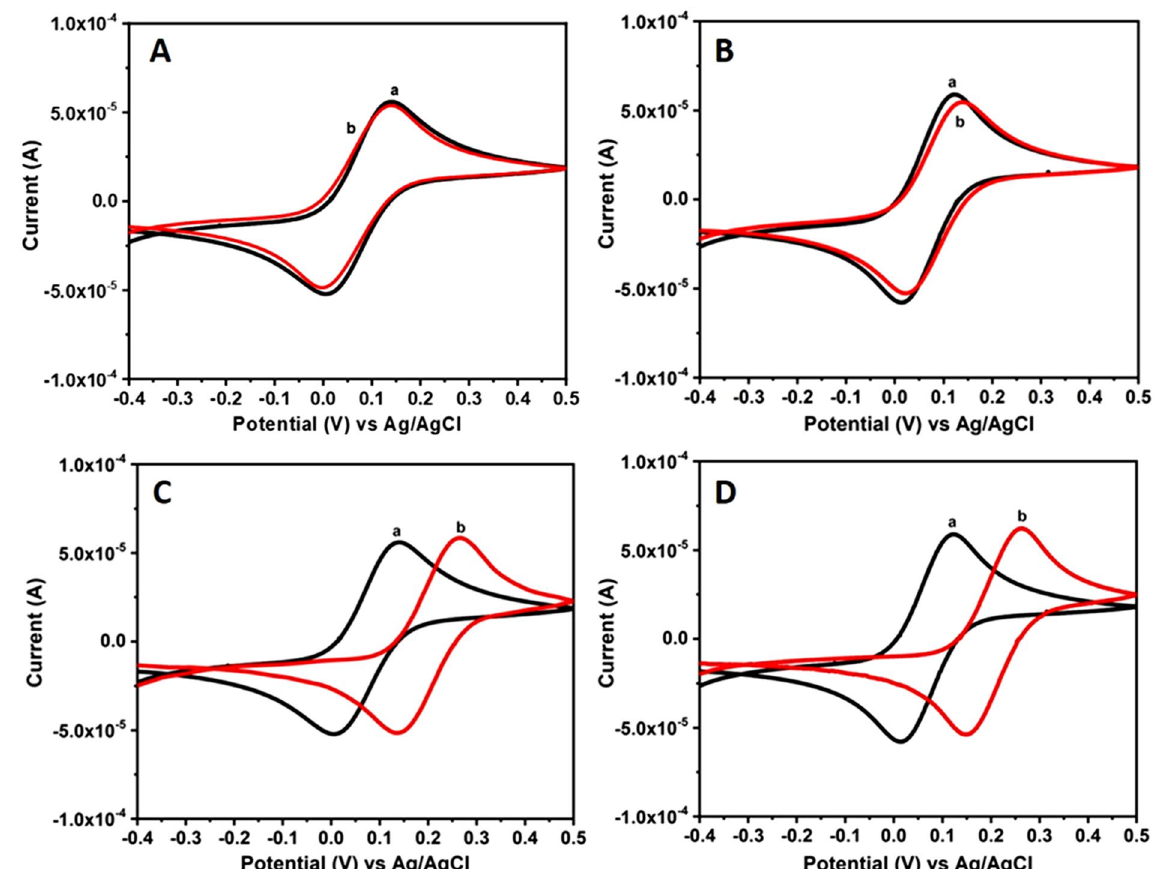
Figure 2. CV curves of Au and Pt electrodes recorded using sweat and saliva bio-mimic solutions at a fixed scan rate of 50 mV/s. ( A ) Au and ( B ) Pt electrodes in artificially simulated sweat solution + Fe 2+/3+ redox couple. Similarly ( C ) Au and ( D ) Pt electrodes in artificial saliva solution + Fe 2+/3+ redox couple. These CVs are recorded for 1 mM [Fe(CN) 6 ] 3−/4− redox couple containing 0.1 M NaCl in absence (a) and in presence (b) of either sweat or saliva compositions